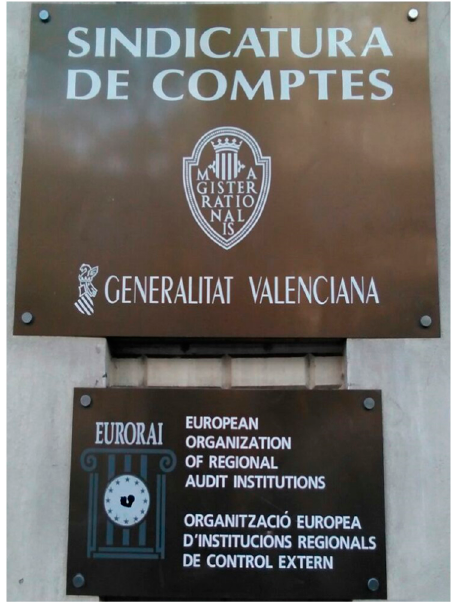
Figure 21. Valencia: Bilingual sign on an official institution .